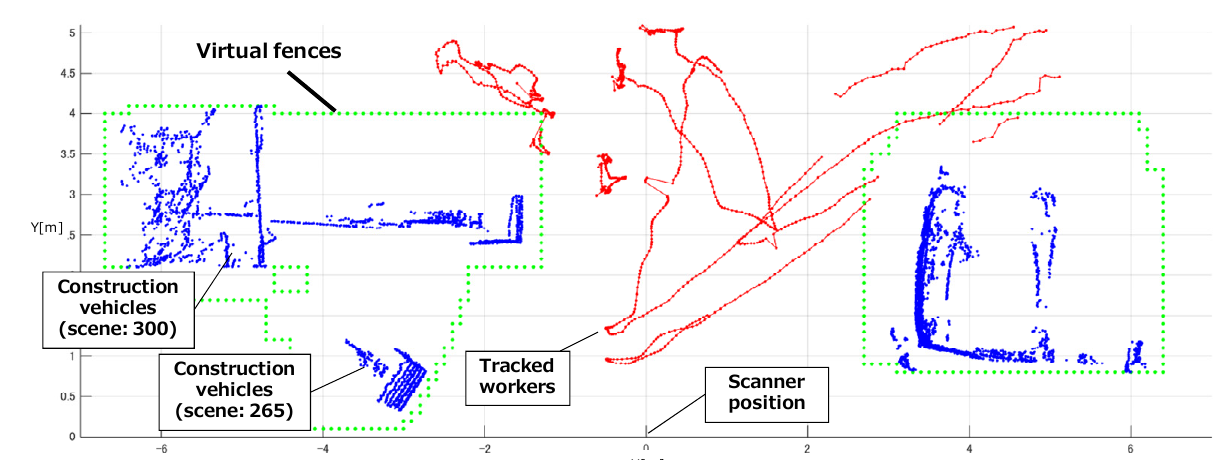
Figure 13. Worker tracking result in a construction environment (plane